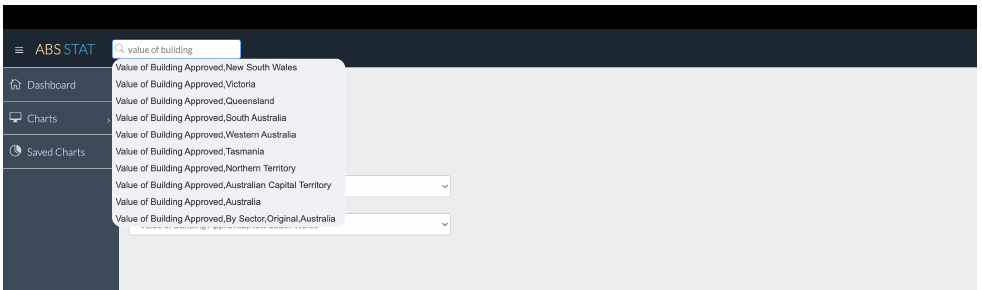
Figure 3. Auto-complete